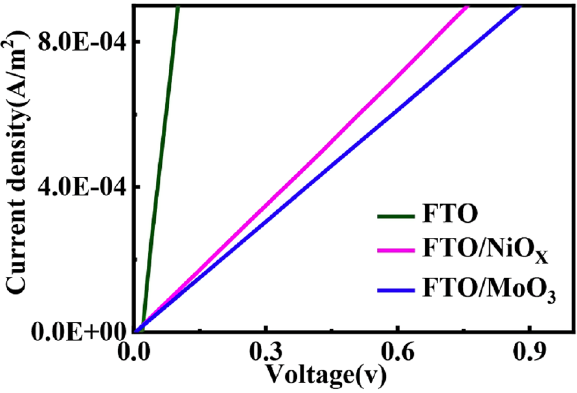
Figure 7. Dark J–V analysis for films CISe on different substrates.